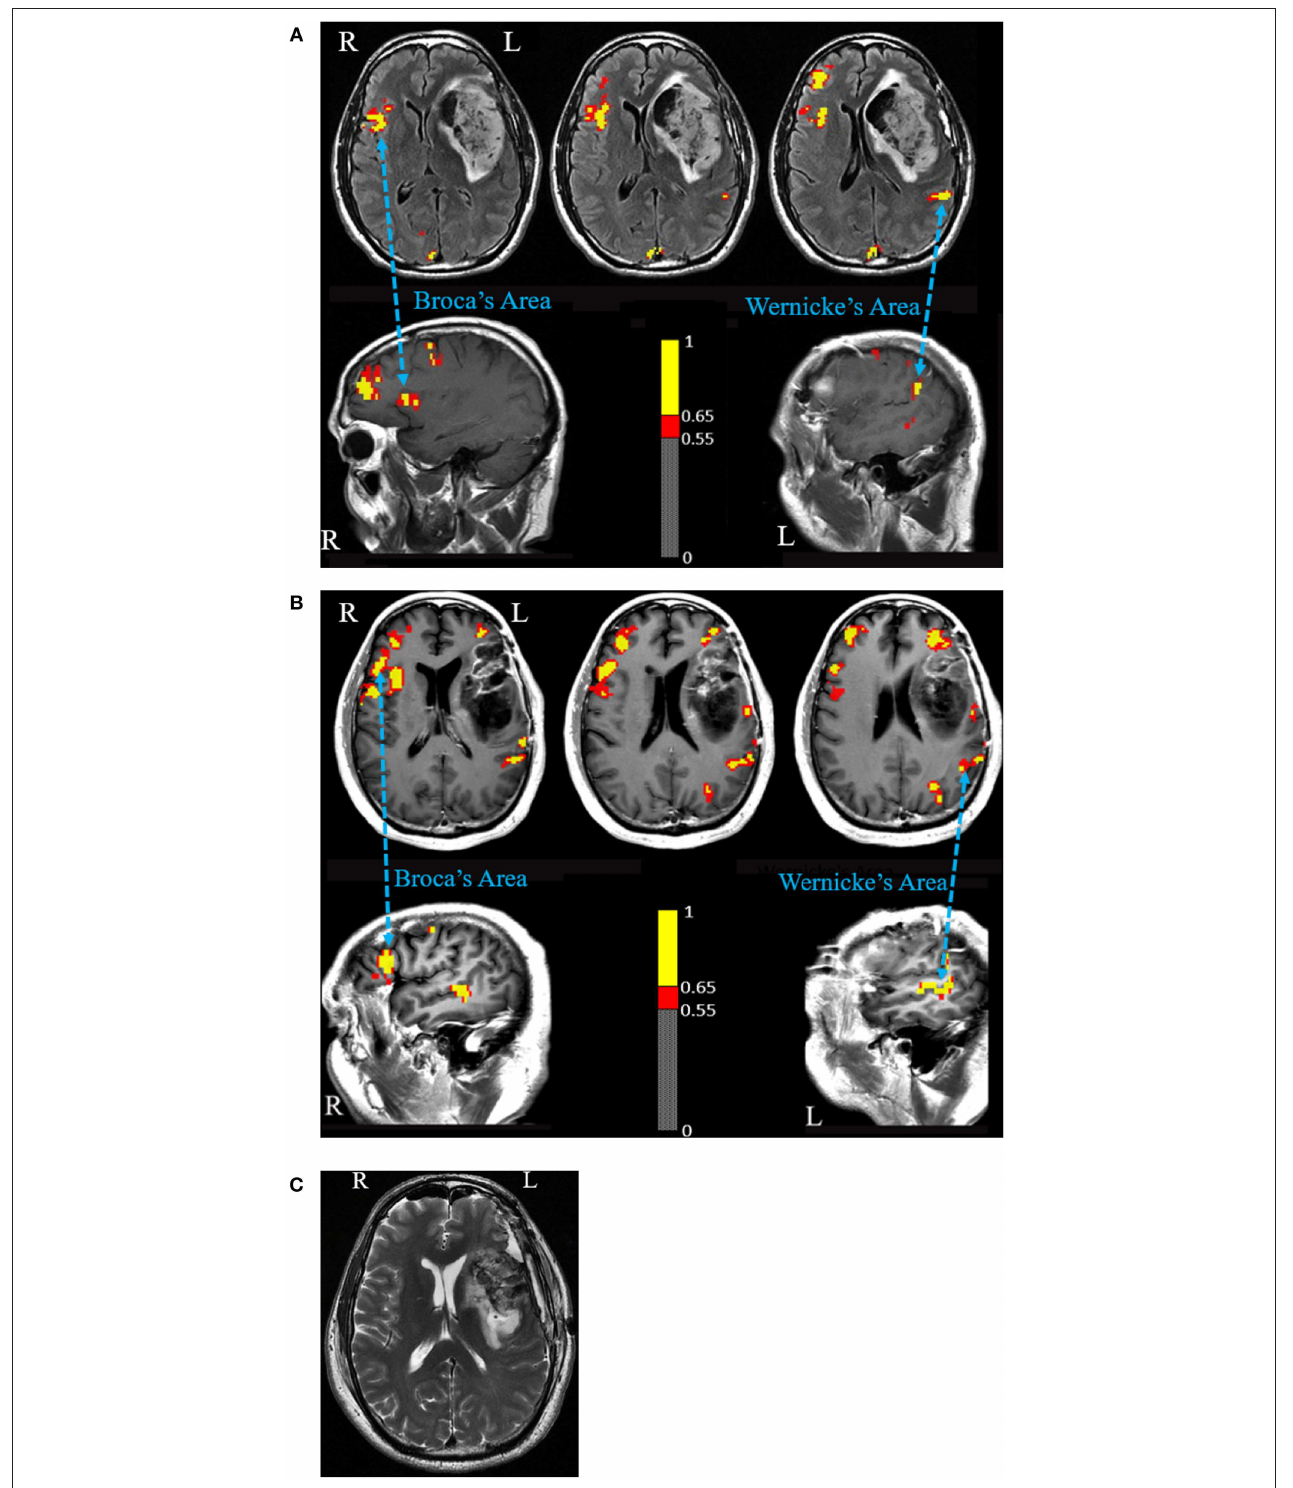
FIGURE 1 | (A) Language fMRI prior to first surgery. A semantic fluency task fMRI shows activated Broca’s Area homolog in the right hemisphere and Wernicke’s Area in the left hemisphere. The figure shows voxels activated at a correlation coefficient of 0.54 ( p = 3.8 × 10 − 8 ) or higher. (B) Language fMRI prior to second surgery. A verbal fluency task shows activated Broca’s Area homolog in the right hemisphere and Wernicke’s Area in the left hemisphere. Activation was also seen anterior and